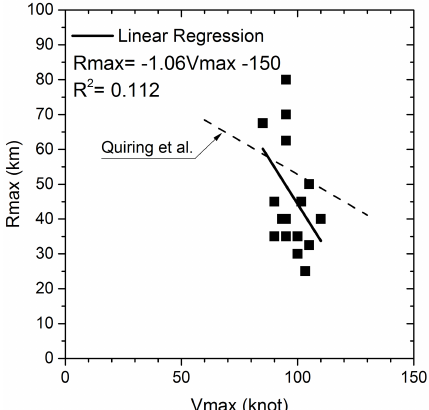
Figure 4. Estimated wind radii ( R max ) versus maximum wind speeds ( V max ) for the 17 studied tropical cyclones. The estimation by Quiring et al. (2011) is also presented after a mean wind speed conversion according to Sampson et al. (1995) (i.e., 10min mean speed = 0.88 × 1min mean